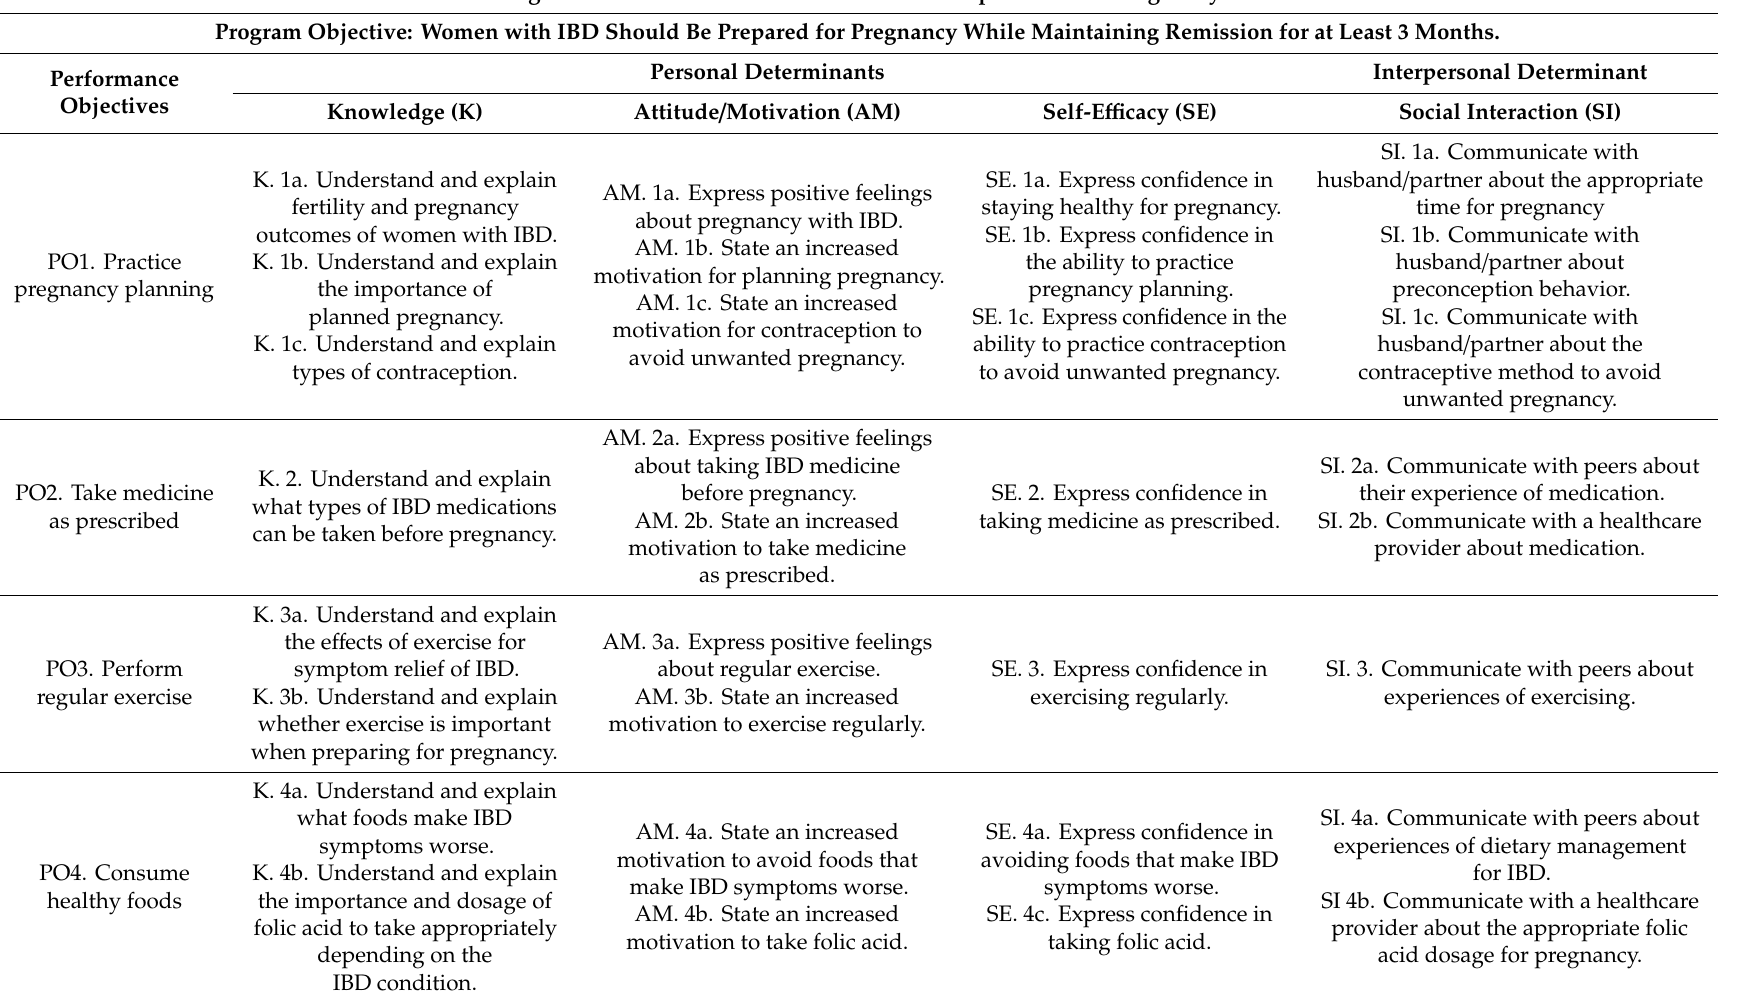
Table 2. Matrix of the preconception care program for women with IBD. Program Goal: Women with IBD Should be Prepared before